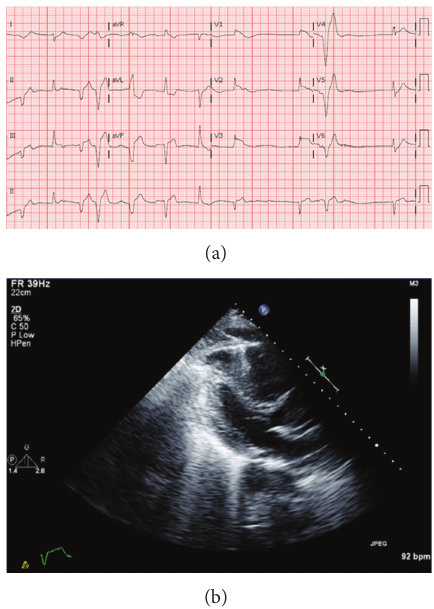
Figure 1: 12-lead EKG showing frequent premature ventricular complexes (PVC), complete right bundle branch block, and ST segment elevation in anterior leads. Parasternal long axis view showing severe RV volume and pressure